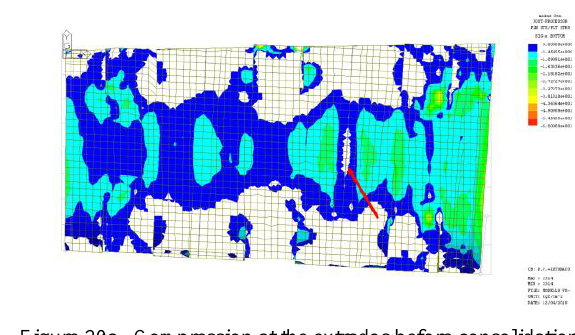
Figure 19a. Compression at the intrados before consolidation